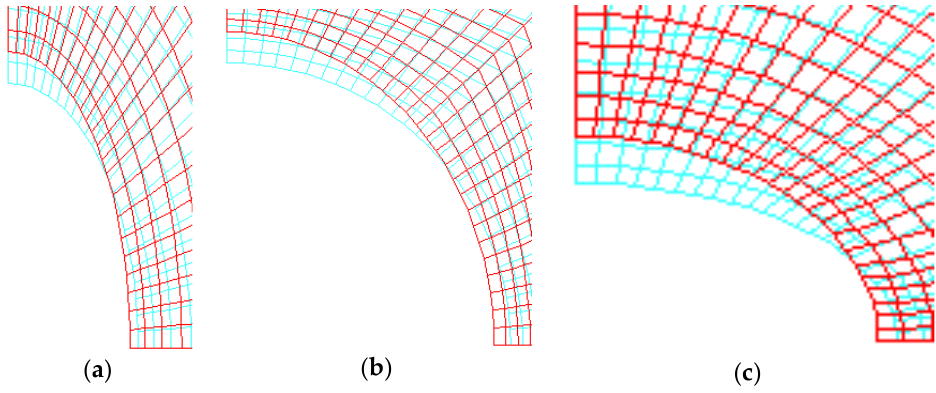
Figure 6. Undeformed (blue) and deformed (red) distributions of total displacements around the hole—the finite element analysis (not to scale): ( a ) vertical ellipse, ( b ) circular, ( c ) horizontal ellipse.